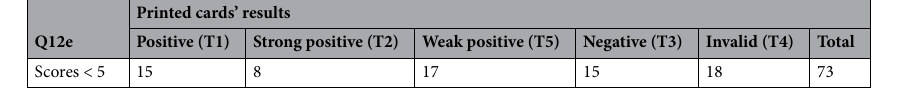
Table 8. The counts for participants’ confidence levels scored under 5 when reading the result (Q12e) and the ground truth provided in their printed cards.